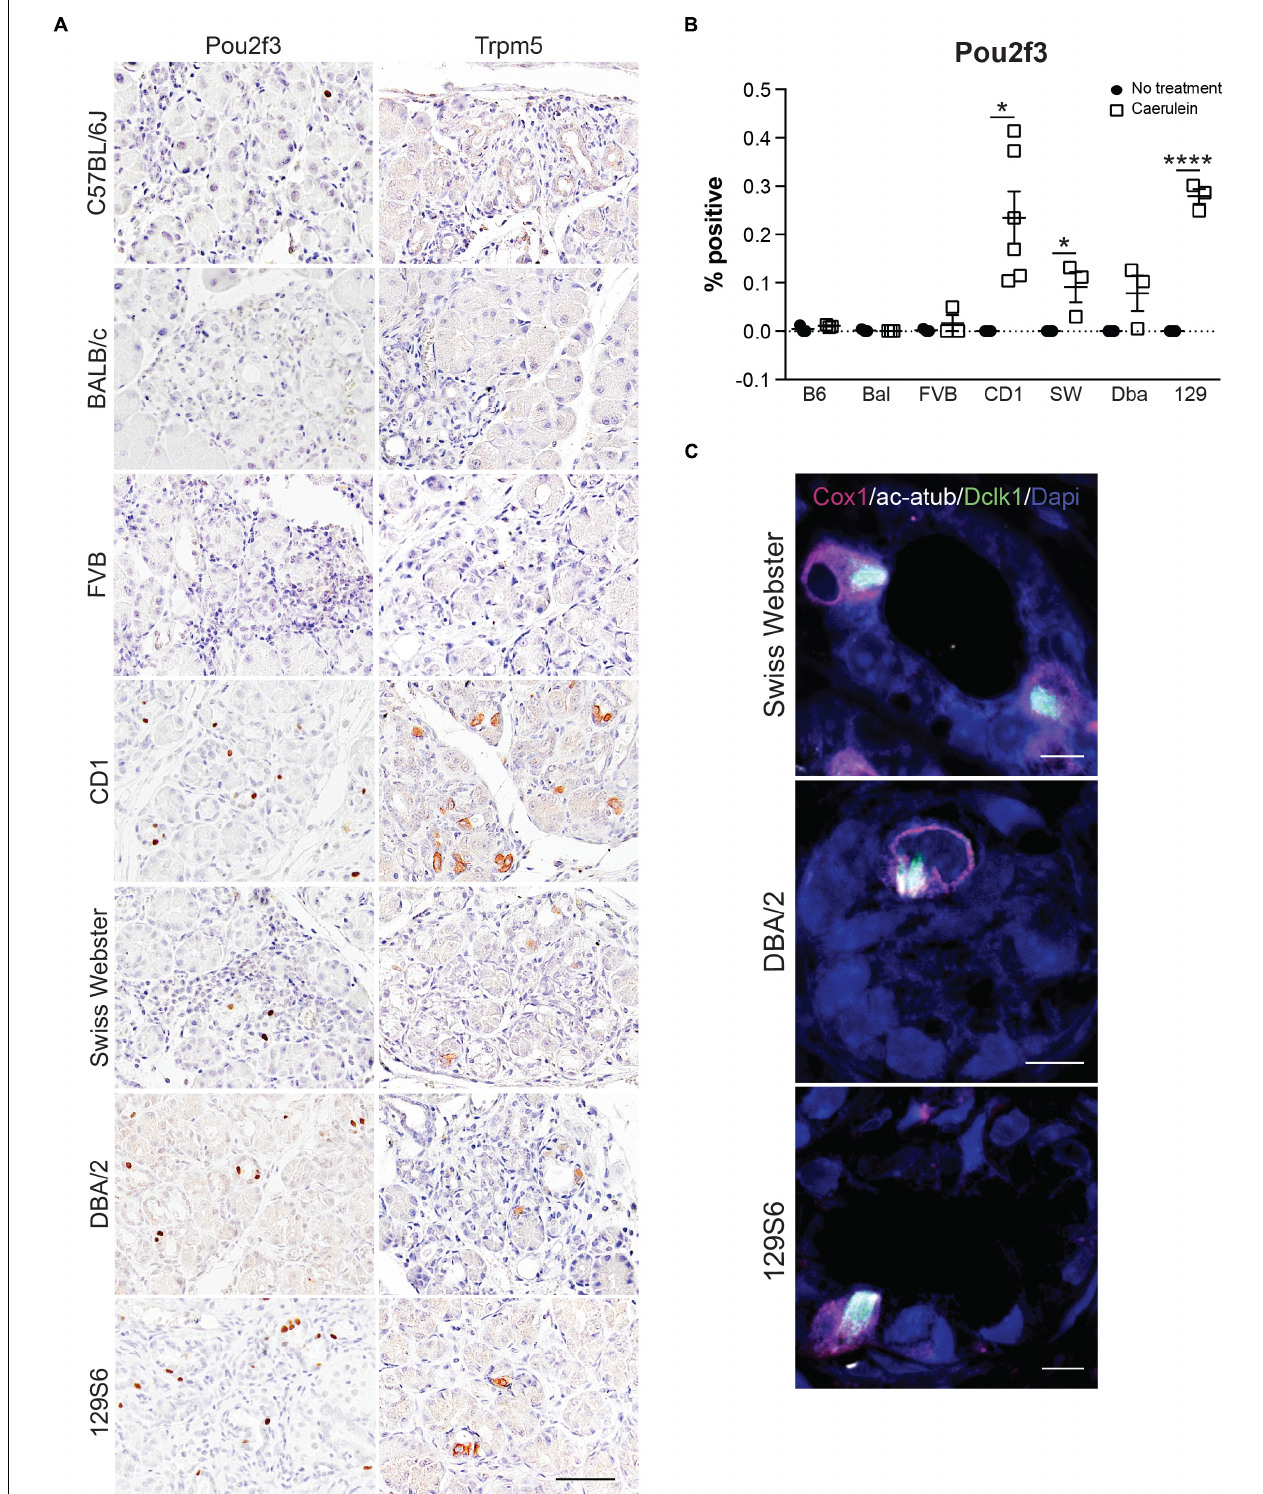
FIGURE 6 | Tuft cell marker expression in response to pancreatitis in wild type mice is strain-dependent. (A) IHC for tuft cell markers Pou2f3 and Trpm5 in all strains. Scale bar, 50 µ m. (B) Quantification of Pou2f3 IHC in all seven strains of mice. (C) Co-immunofluorescence for tuft cell markers Cox1 (pink), acetylated α -tubulin (white), and Dclk1 (green). Scale bar, 5 µ m. Bal, BALB/c; SW, Swiss Webster; Dba, DBA/2; 129, 129S6. * p < 0.05; **** p < 0.001.